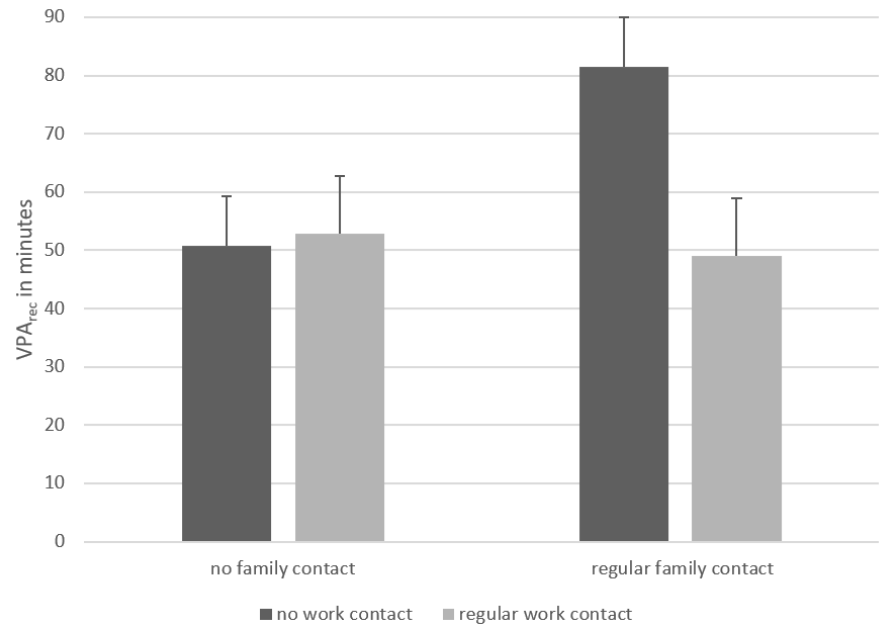
Figure 3. Interaction e ff ect of contact within family and related to work in vigorous intensity.